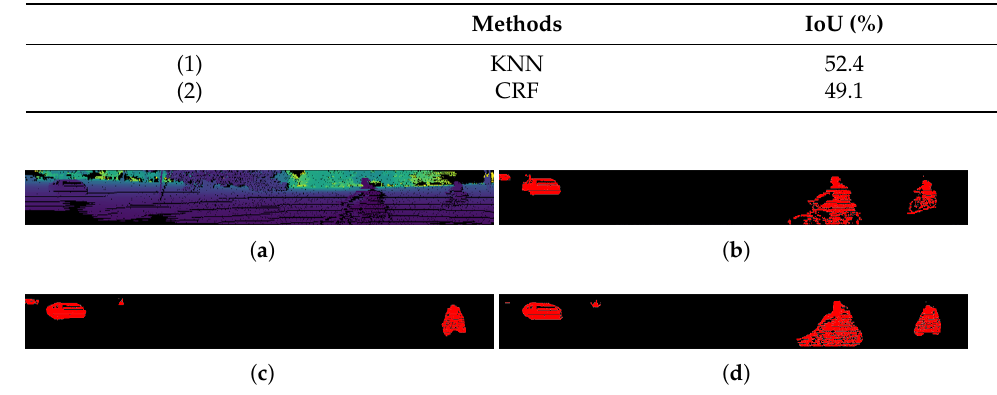
Figure 5. Qualitative results of different post-processing methods for MOS on the validation set, where red pixels correspond to moving objects (range view images). ( a ) Range Image; ( b ) Ground Truth Labels; ( c ) CRF; ( d )